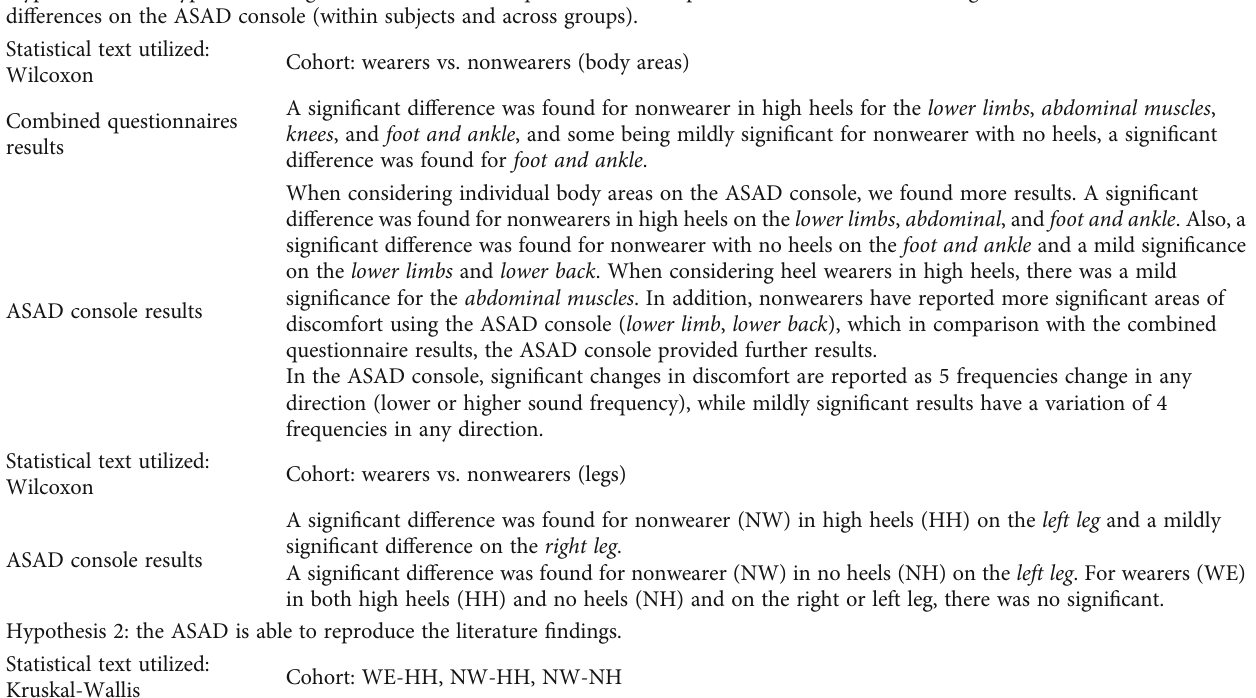
Table 3: Summarizing hypothesis, statistical test utilized, and signi fi cant results from this study. Hypothesis 1: we hypothesized signi fi cant di ff erences in questionnaires ’ responses before and after the fatigue test to translate into di ff erences on the ASAD console (within subjects and across